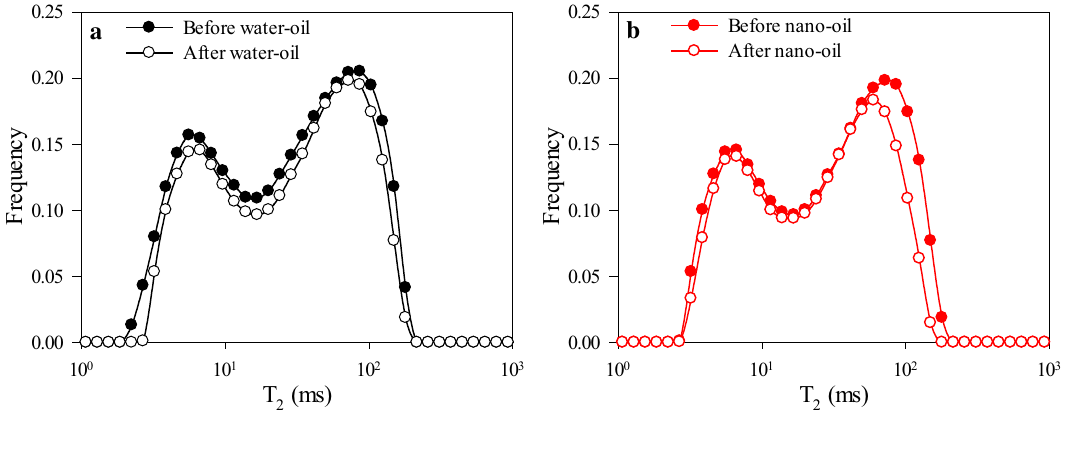
Fig. 5 NMR T 2 distribution for